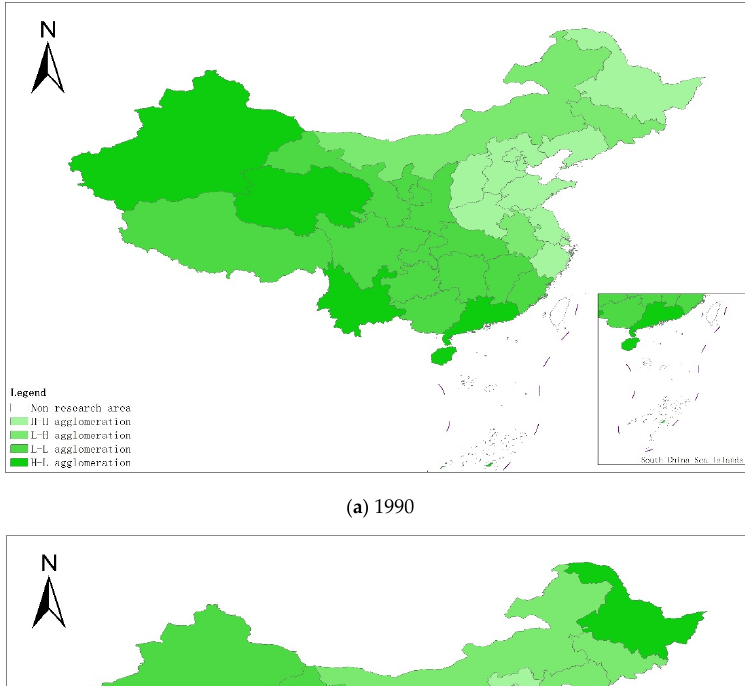
19 of 27 Figure 5. Scatter plot of local Moran index of the coupling coordination degree of China’s indus- trialization and agricultural green development in some years ( a – g ). (a) 1990; ( b ) 1995; ( c ) 2000; ( d ) 2005; ( e ) 2010; ( f ) 2015; ( g ) 2019. Data Source: the authors calculated based on China Statistical Yearbook, China Industrial Statistical Yearbook, China Rural Statistical Yearbook, China Regional Economic Statistical Yearbook. In order to more intuitively understand the agglomeration or dispersion of various provinces, the data of each quadrant is summarized and presented in the form shown in Figure 6. From the perspective of time dynamics, the level of AGD in various regions has